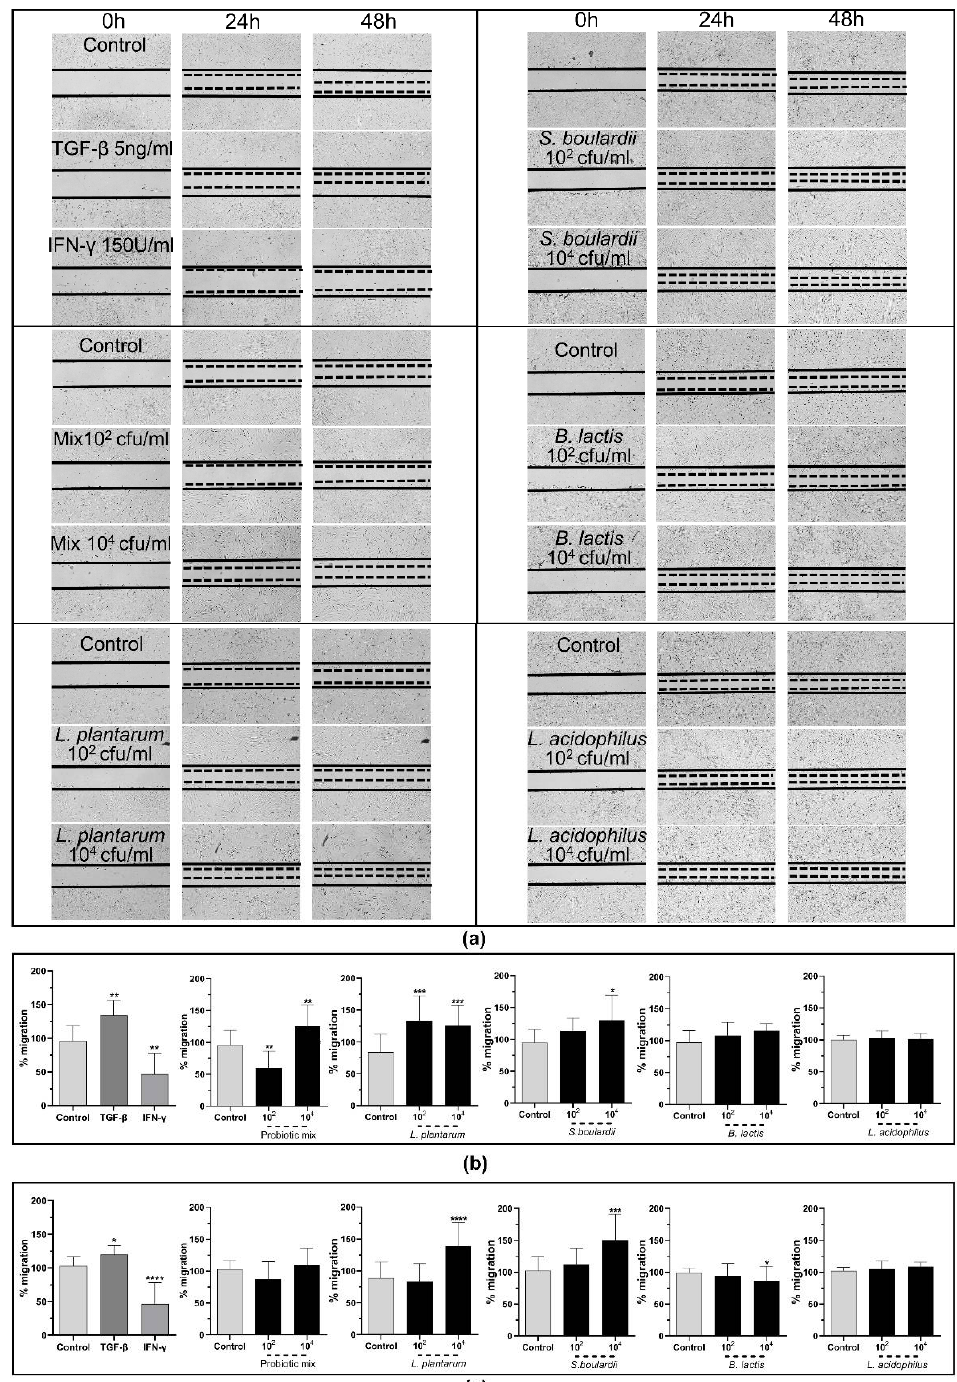
Figure 12c) and Lactobacillus acidophilus stimulation did not affect it significantly (Figure 12b,c).